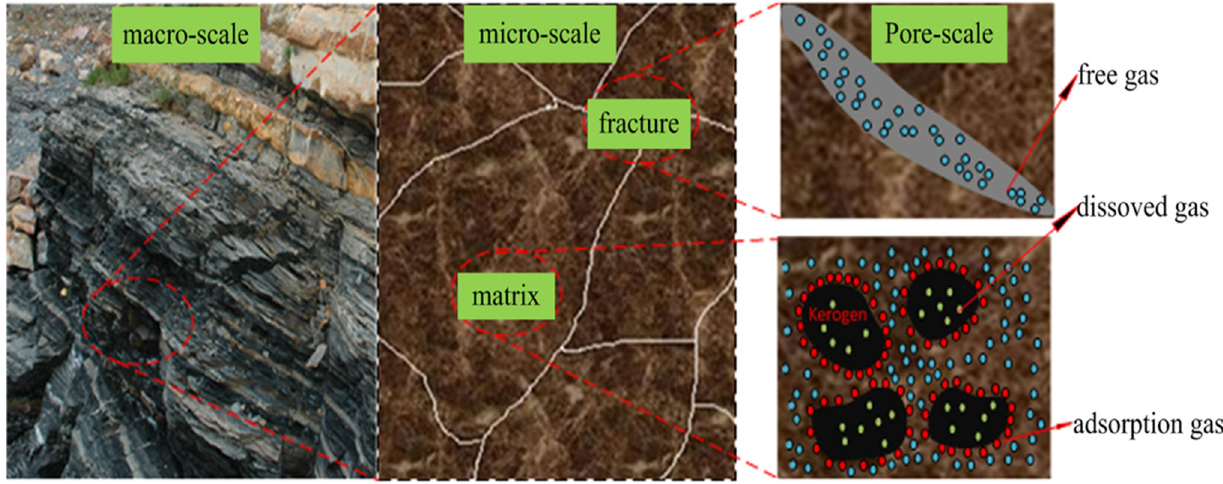
Fig. 3 Gas distributions in shale formation macro-scale to micro-scale. Free gas is found within fractures and adsorption gas is present in the matrix (e.g. Guo et al.